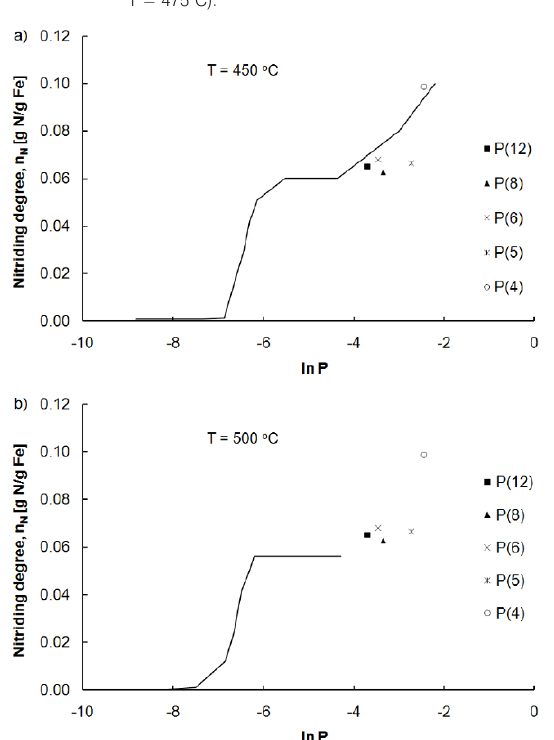
Figure 3. Nitriding degree as a function of the natural logarithm of nitriding potential.